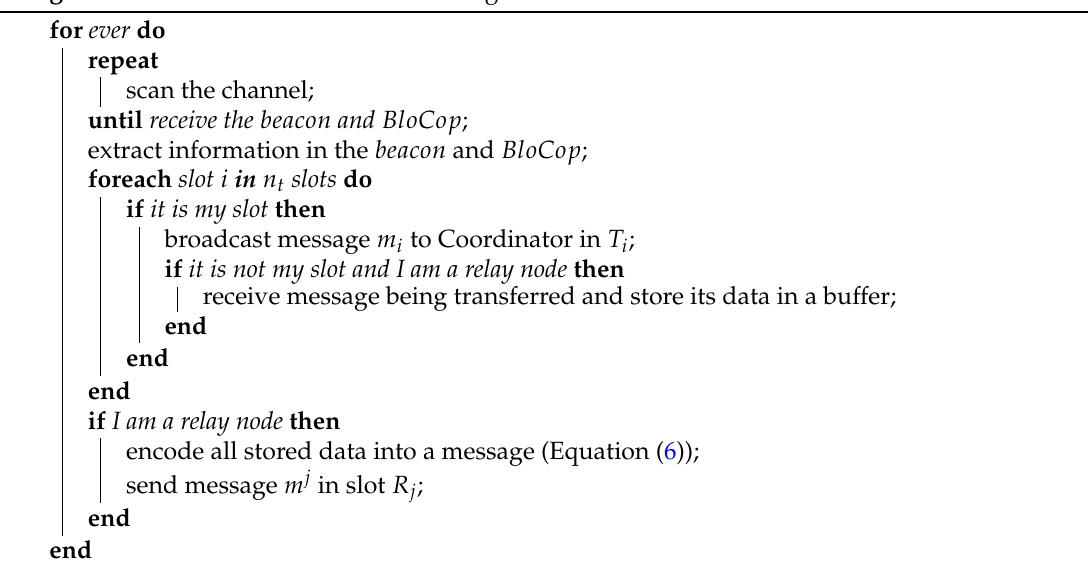
Algorithm 2: Overview of sensor nodes algorithm.